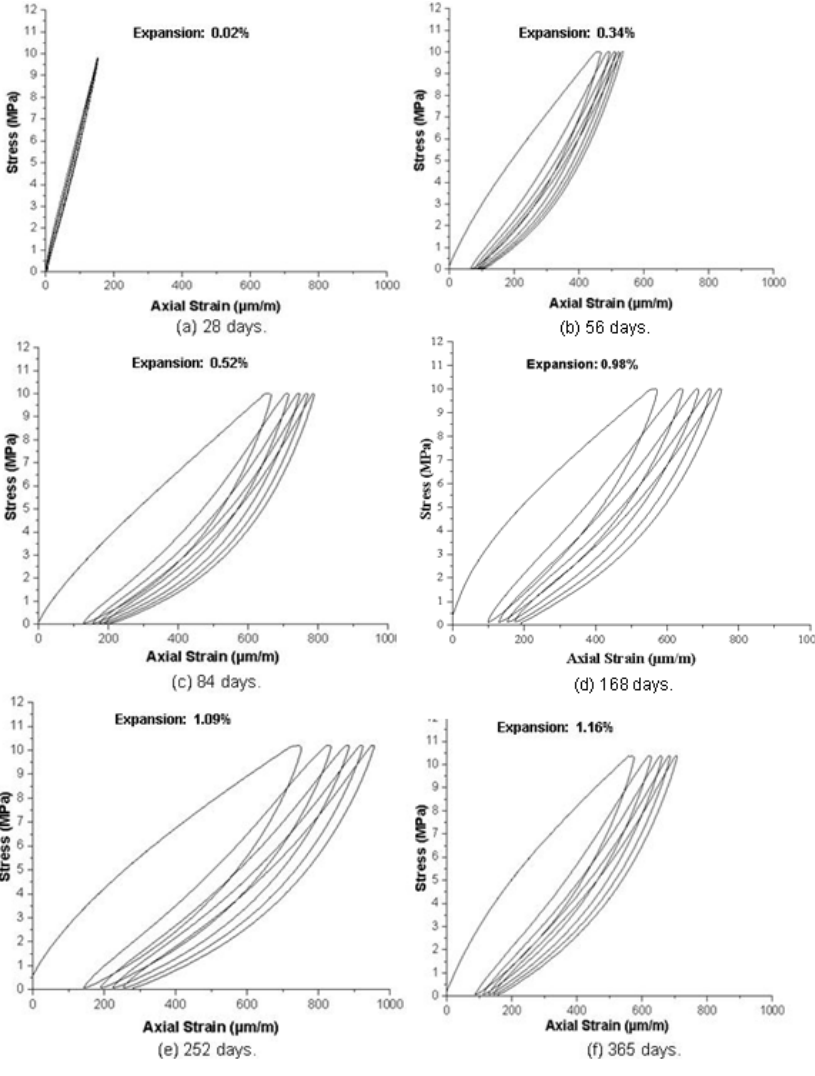
Figure 15. Results of Stiffness Damage Test (SDT) for Type III